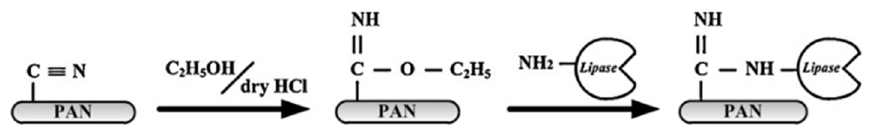
Figure 7. Schematic illustration of Pseudomonas cepacian lipase immobilized onto the polyacrylonitrile nanofibrous membrane by activating with the amidination reaction [102].